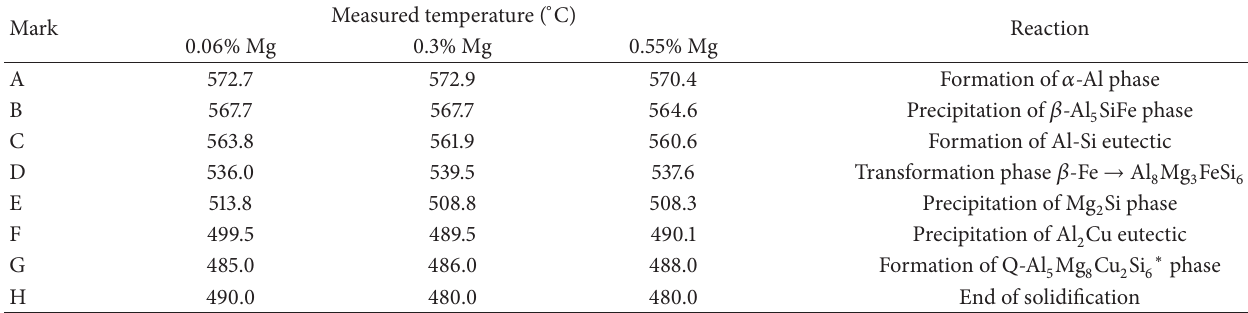
Table 3: Solidification reactions obtained from the three studied